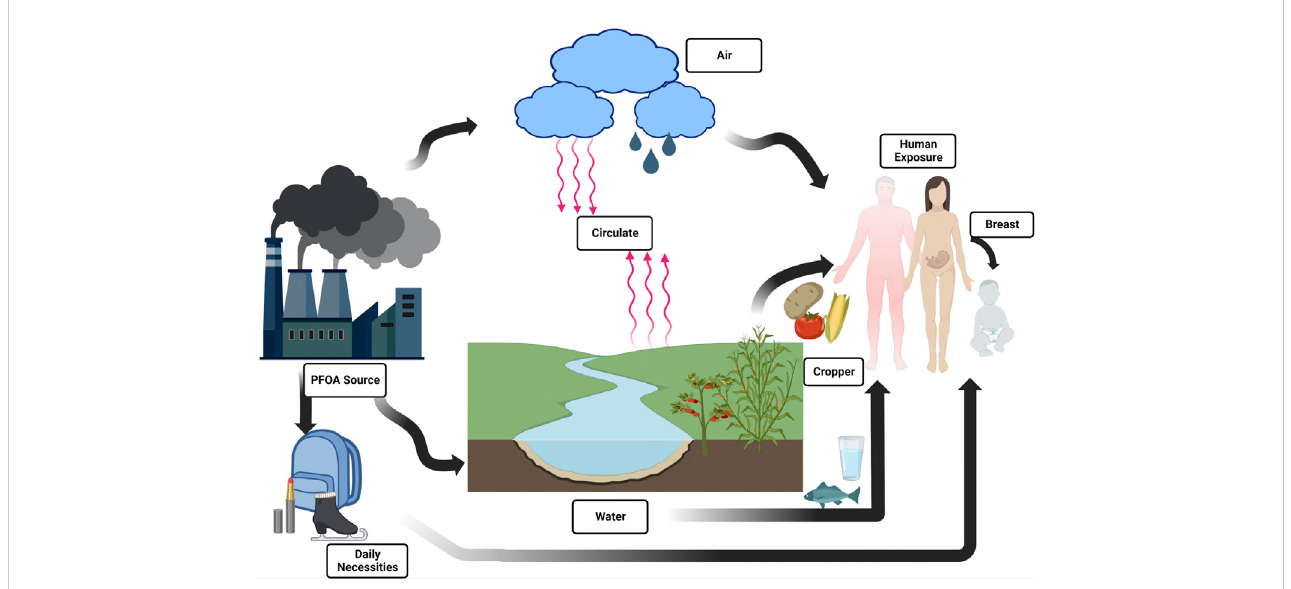
Overview of PFOA exposure pathways for different human populations outside of occupational settings.